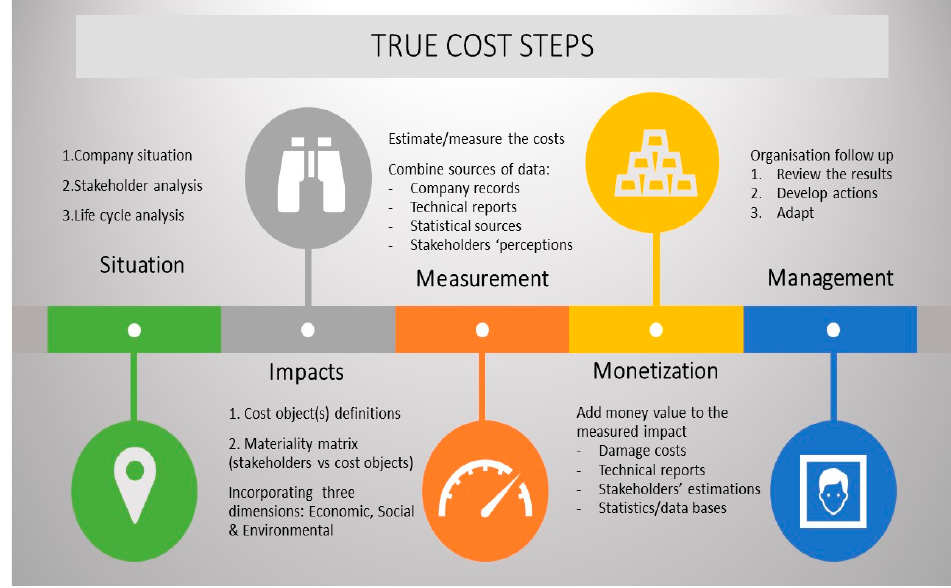
Figure 1. True Cost Accounting framework. Source: